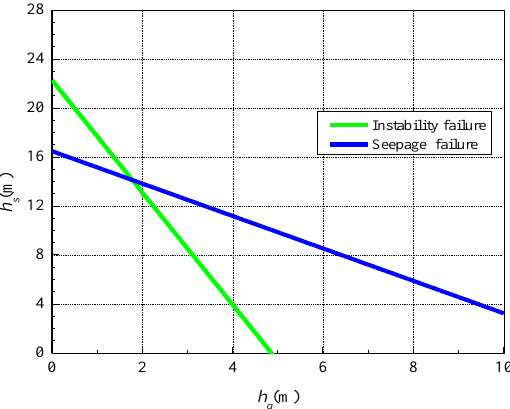
Figure 8. Relation curve of depth h s versus thickness h g of jet-grouted bottom sealing barriers.